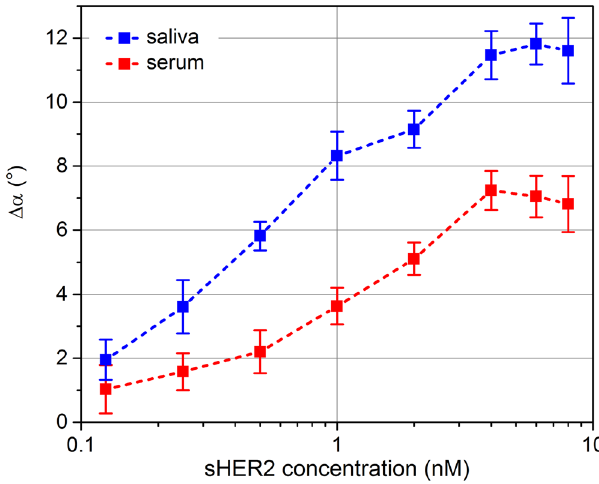
Figure 3. Phase lag difference signal Δα in 10-fold diluted solutions of spiked serum and saliva and its dependence on the antigen concentration. Measurement signal in saliva (blue curve) and in serum (red curve) under addition of 2 nd